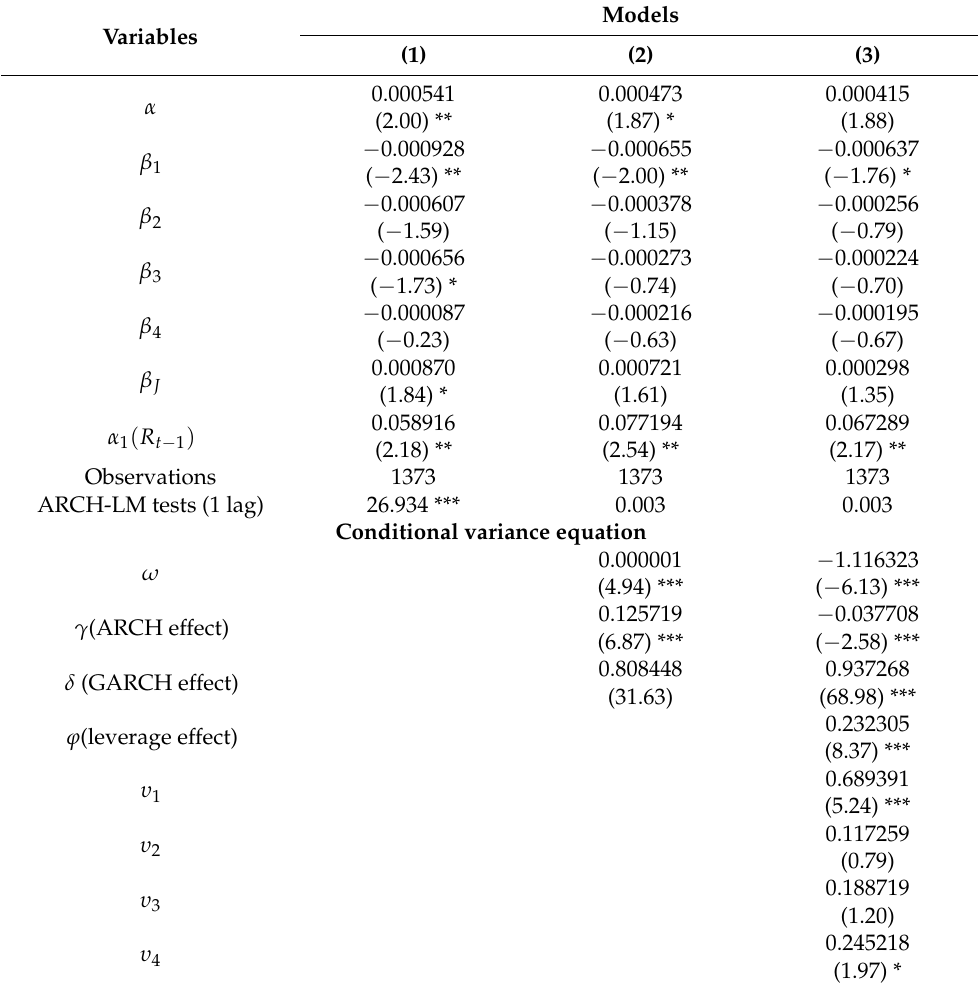
Table 6. Empirical findings for the pre-index future